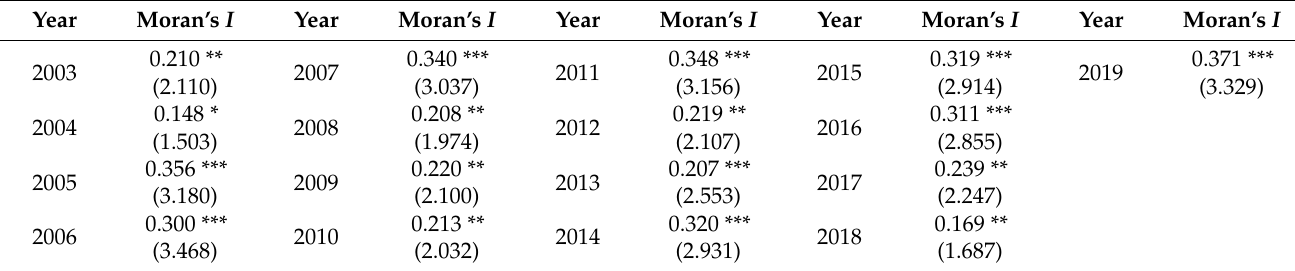
Table 6. Global spatial Moran index of WLF nexus for 2003 – 2018.